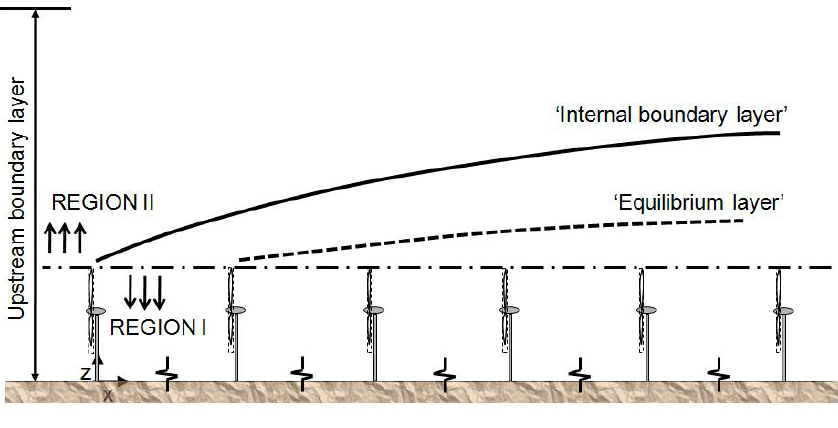
Figure 9. Conceptual description of the different regions and layers in a wind